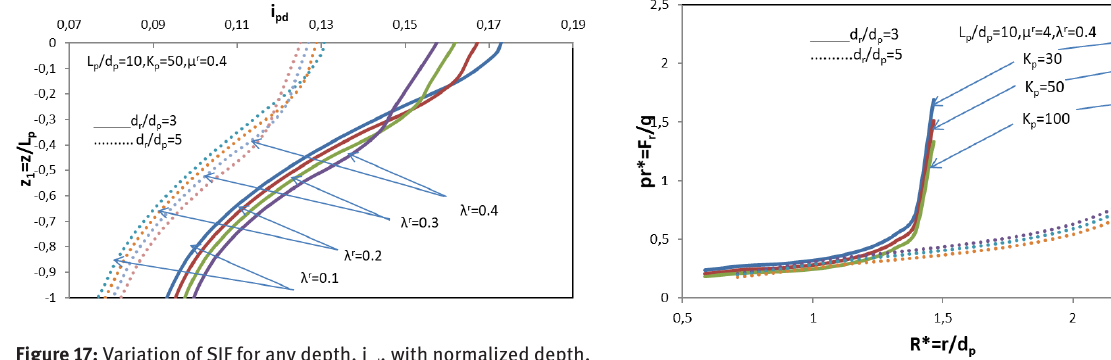
, with normalized depth, pd Figure 19: Variation of contact pressure (p /d =10, K =50, p p p distance from the center of raft R*=r/d strengthening, K